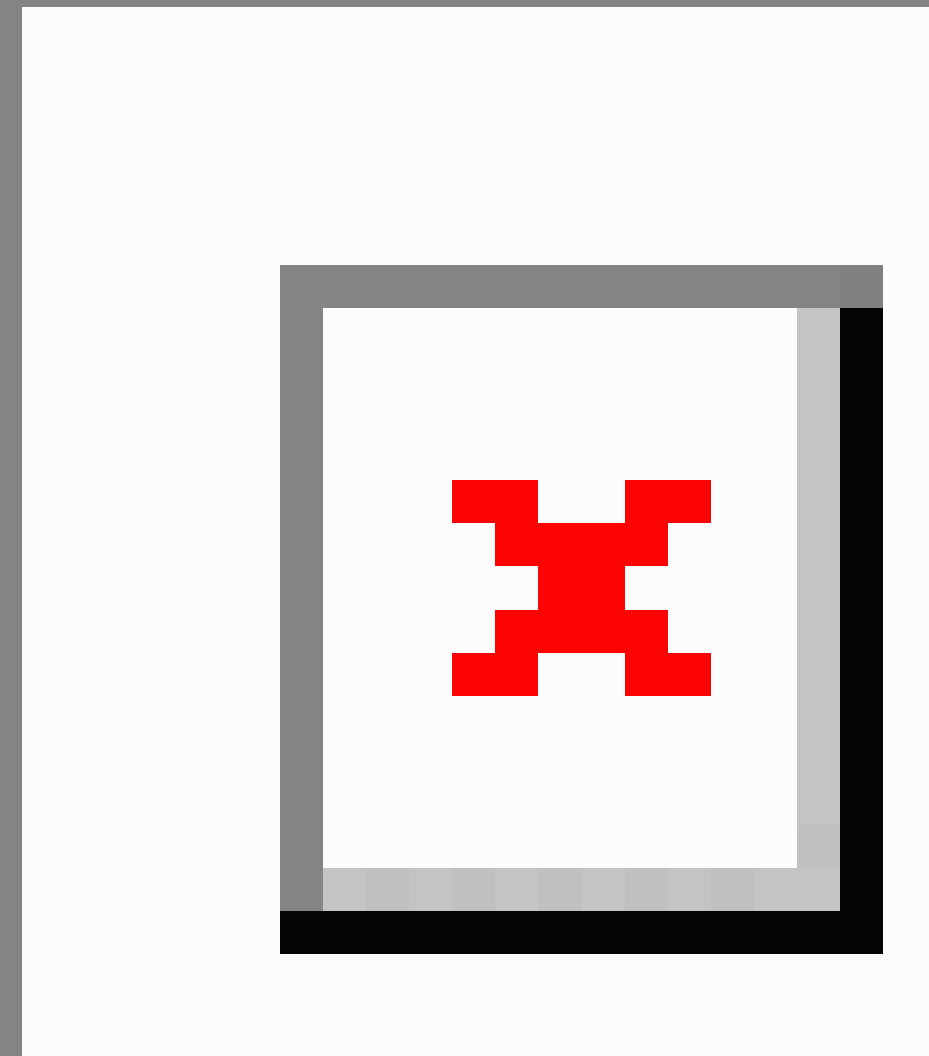
Figure 2. Flow of participants through the study.